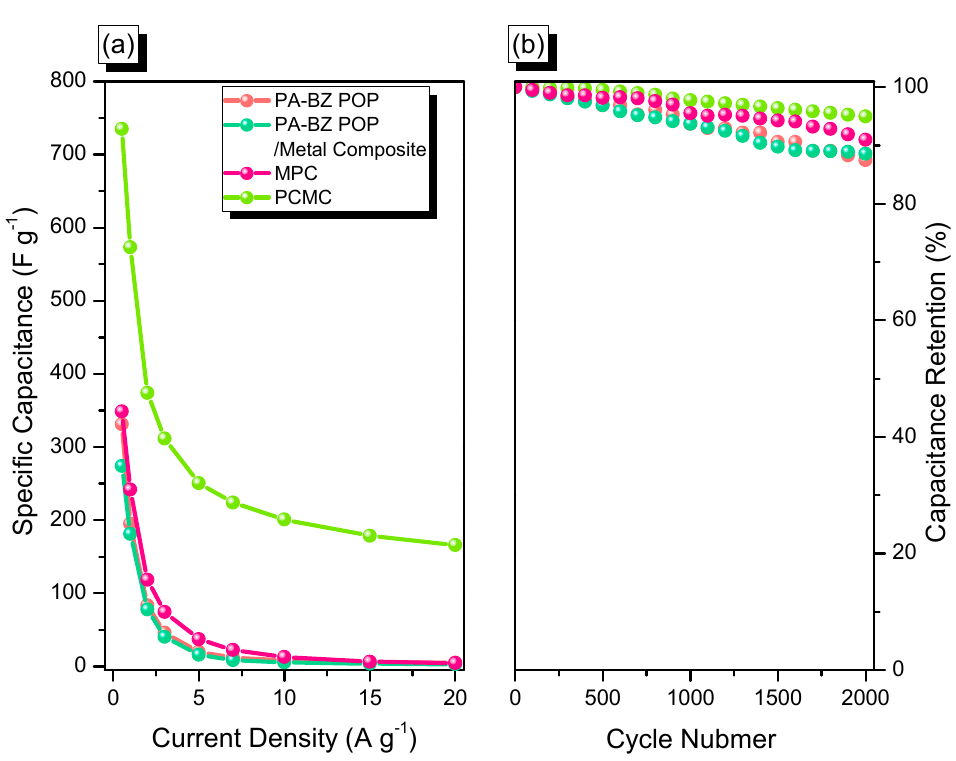
Figure 11 . ( a ) Specific capacitance and ( b ) stability tests of PA-BZ POP, PA-BZ POP/metal composite, MPC, and PCMC.